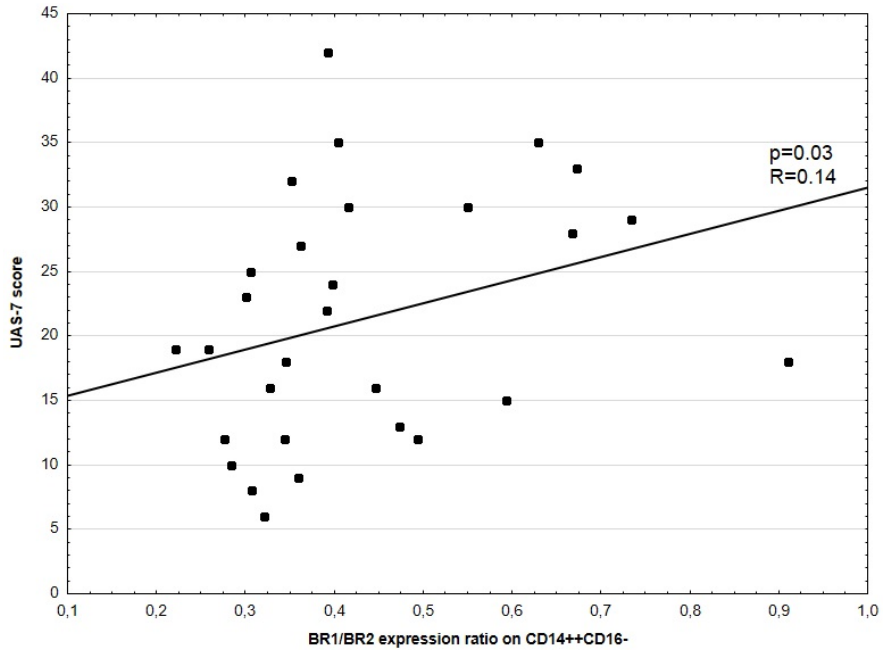
Figure 1. Correlation between UAS-7 score and BR1/BR2 expression ratio in CD14 ++ CD16 − cells. Each dot represents one patient with their ID.